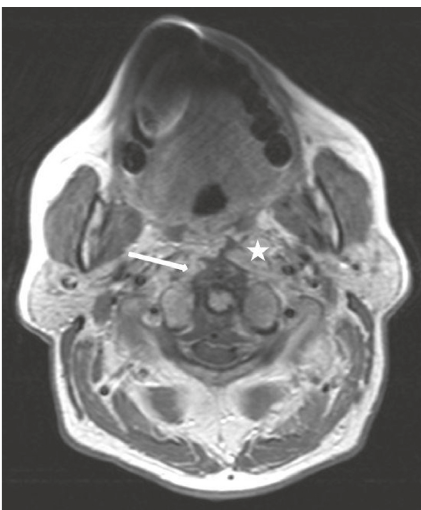
Figure 2: Axial MRI slice five days after incision and drainage of the prevertebral abscess: contrast-enhanced T1-weighted axial MRI scan shows the incised abscess cavity (white asterisk) which is connected to a progressive fluid retention especially in the area between the dorsal ligament and the ventral dura with a slight compression of the myelon (white arrow). This epidural abscess ranged from the foramen magnum to the upper ridge of the third cervical vertebra.